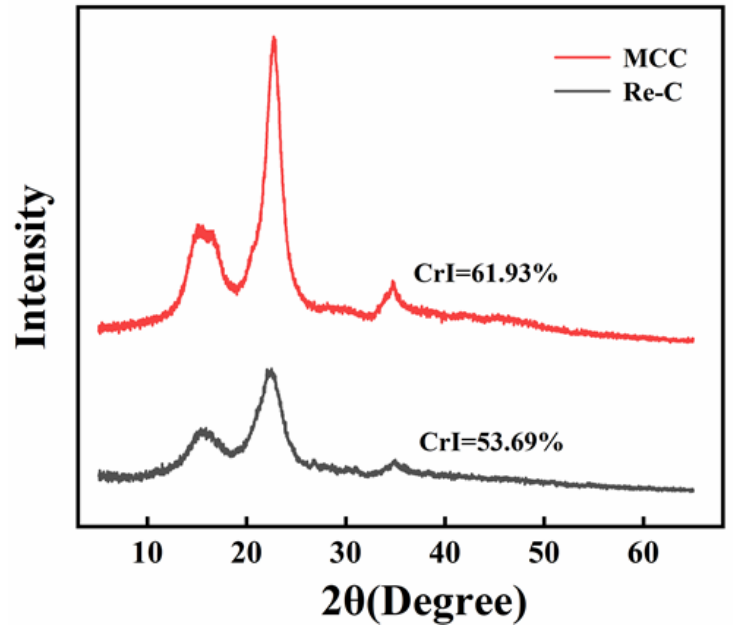
Figure 9. XRD spectra of MCC and Re-C.